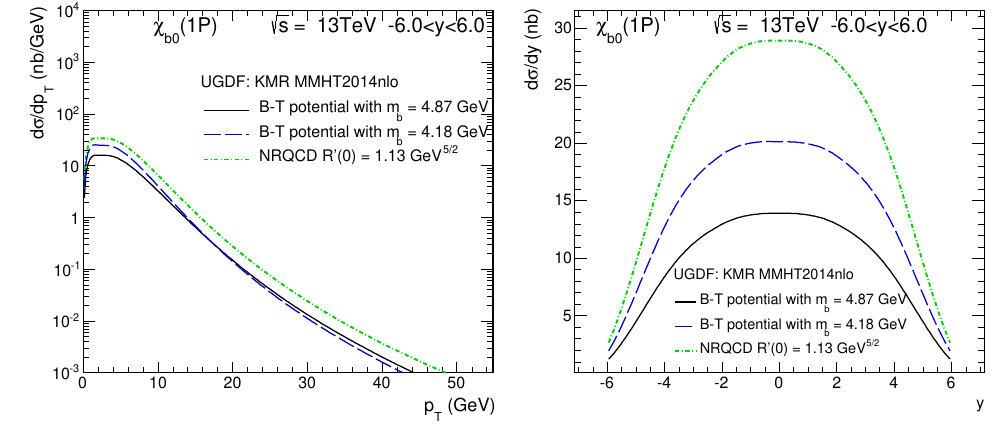
Figure 11 . Comparison of p T distributions for our full model (solid line | with m b = 4 : 87 GeV, dashed line | with m b = 4 : 18 GeV) with the NRQCD result (see eq. (3.21)) (dash-dotted line). Here the BT potential and the KMR UGDF are